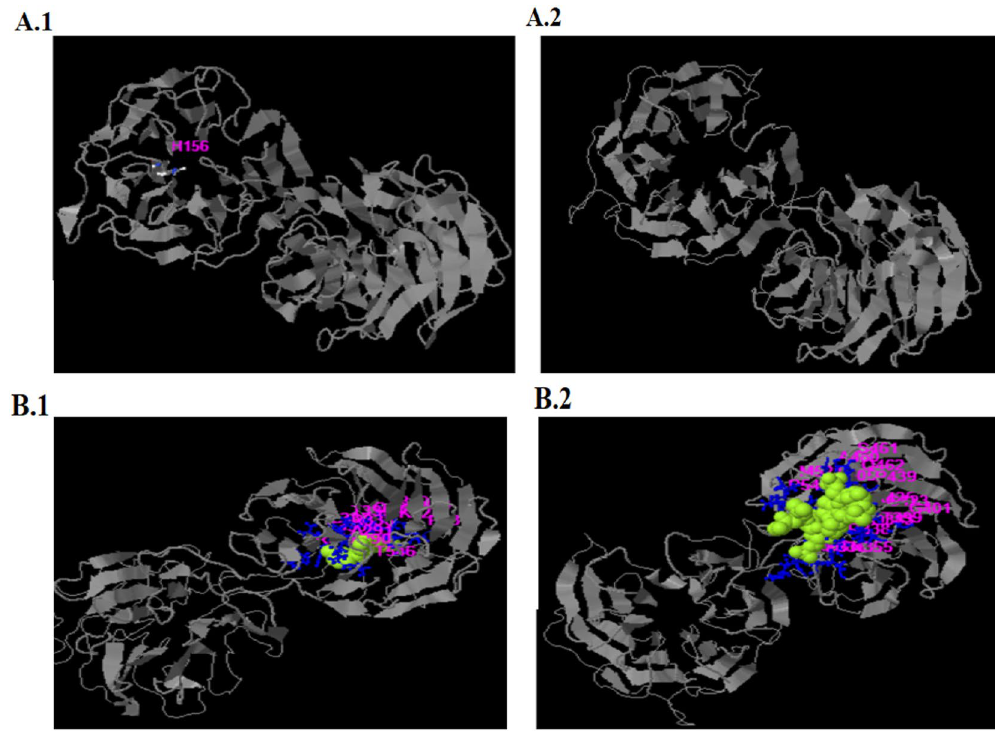
Figure 3. The overall effect of G352R variant on TLE6 structure, binding sites and active sites. ( A ) Comparison of mutant TLE6 binding sites with wild-type. (1. Wild-type/ 2. mutant). ( B ) Comparison of mutant TLE6 active sites with wild-type. (1. Wild-type/ 2. mutant).